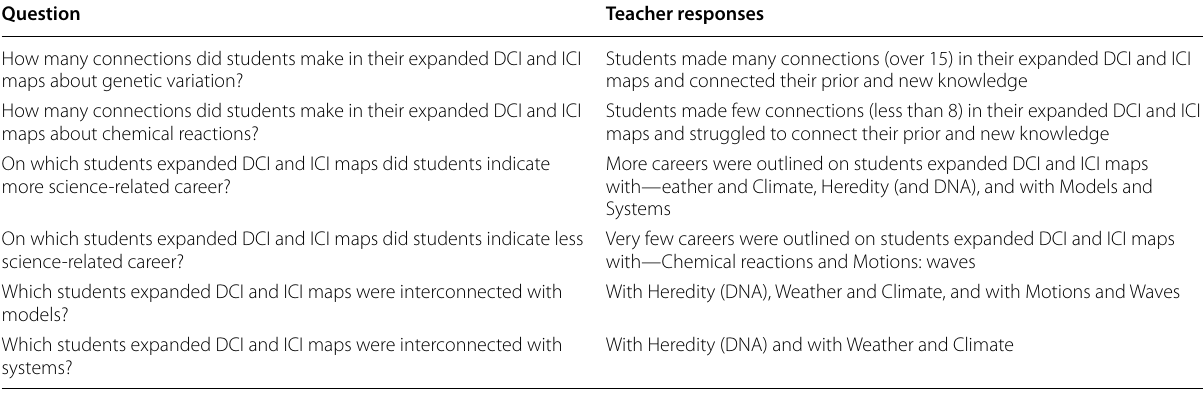
Table 8 Teacher (6) responses related to monitoring the students expanded DCI and ICI maps